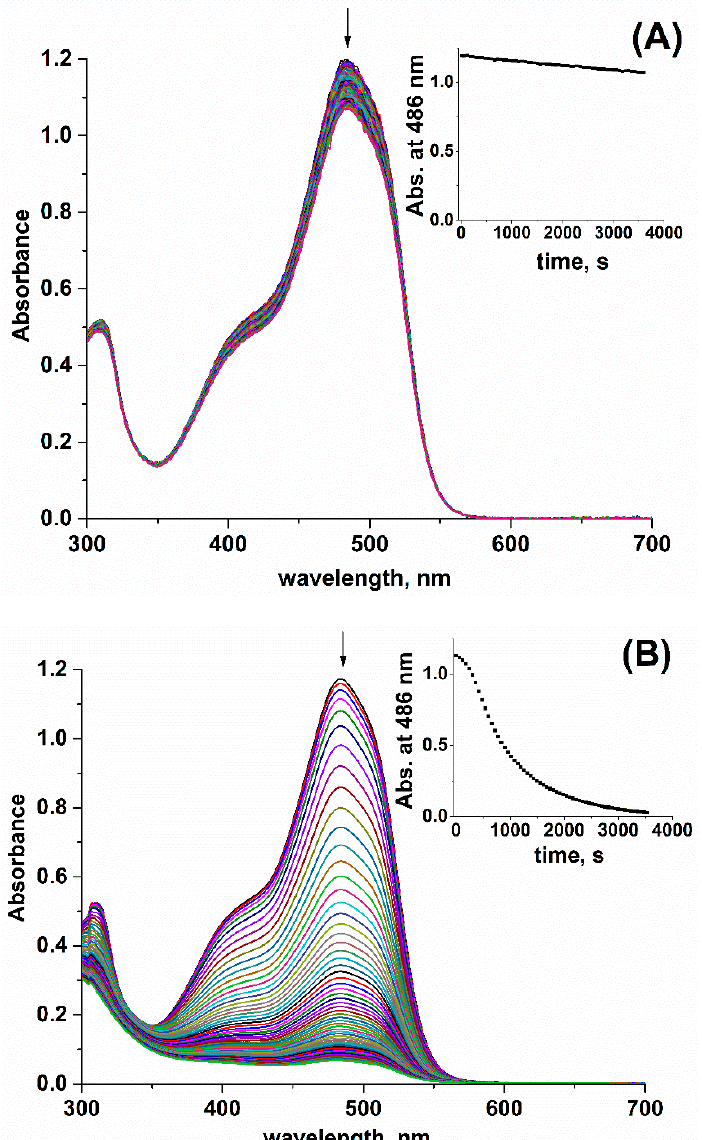
Figure 2. ( A ) UV-vis spectra of the reaction between Orange II (5.7·10 − 5 M) and HSO 5 − (5.0·10 − 4 M) at pH 7.4, 25.0 °C. ( B ) UV-vis spectra of the reaction between Orange II (5.7·10 − 5 M) and HSO 5- (5.0·10 − 4 M) in the presence of H 2 OCbl (1.0·10 − 6 M) at pH 7.4, 25.0 °C. The time interval between the spectra is 60 s. The total reaction time is 60 min. Inset: time-course curves of the reactions.